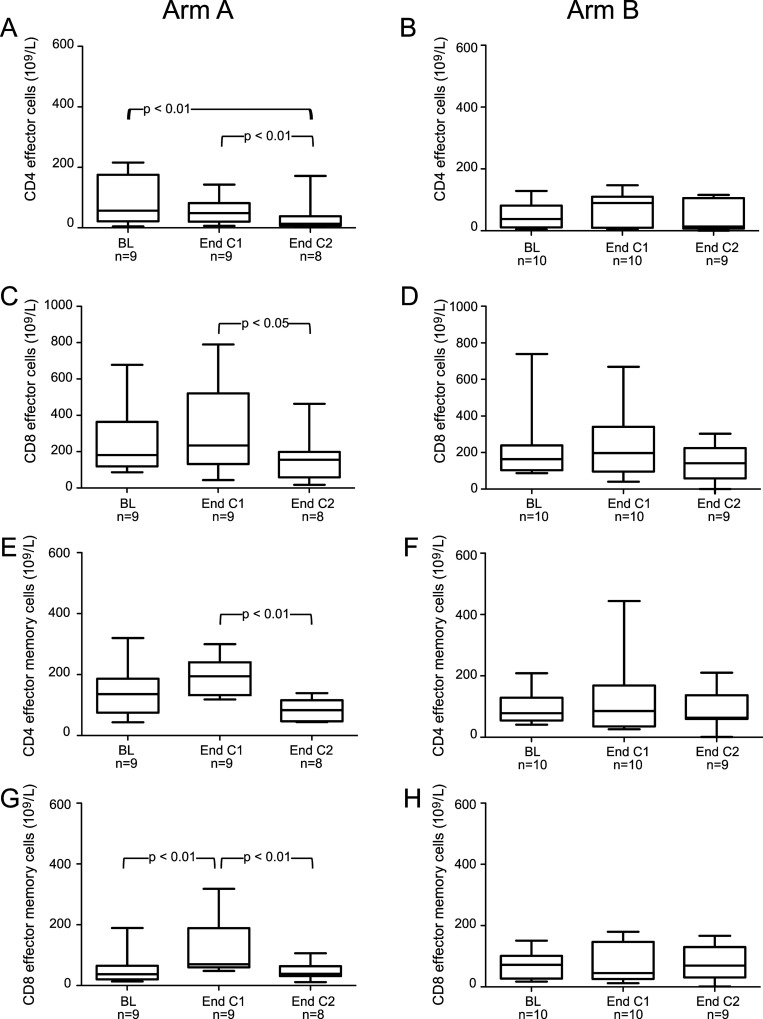
Absolute numbers of subsets of effector and effector memory T cells at baseline (BL), at the end of cycle 1 (End C1) and at the end of cycle 2 (End C2) in part II patients treated with either lenalidomide monotherapy during cycle 1 with the addition of gemcitabine from cycle 2 (Arm A) (Left column) (Fig 3 A, C, E and G) or gemcitabine monotherapy during cycle 1 with the addition of lenalidomide from cycle 2 (Arm B) (Right column) (Fig 3 B, D, F and H). Changes in the absolute numbers of CD8+ effector T cells (CD45RA+CCR7-CD8+) (C, D), CD8+ effector memory T cells (CD45RA-CCR7-CD8+) (G, H), CD4+ effector T cells (CD45RA+CCR7-CD4+) (A-B) and CD4+ effector memory T cells (CD45RA-CCR7-CD4+) (E, F) over the treatment course. n = number of patients analysed at each time-point. P-values refer to the comparison with BL, End C1 and End C2 by one way ANOVA with repeated measures. The box, with a line indicating median, represents the 25th and 75th percentiles. The top and bottom whiskers represent the 90th and 10th percentiles, respectively.